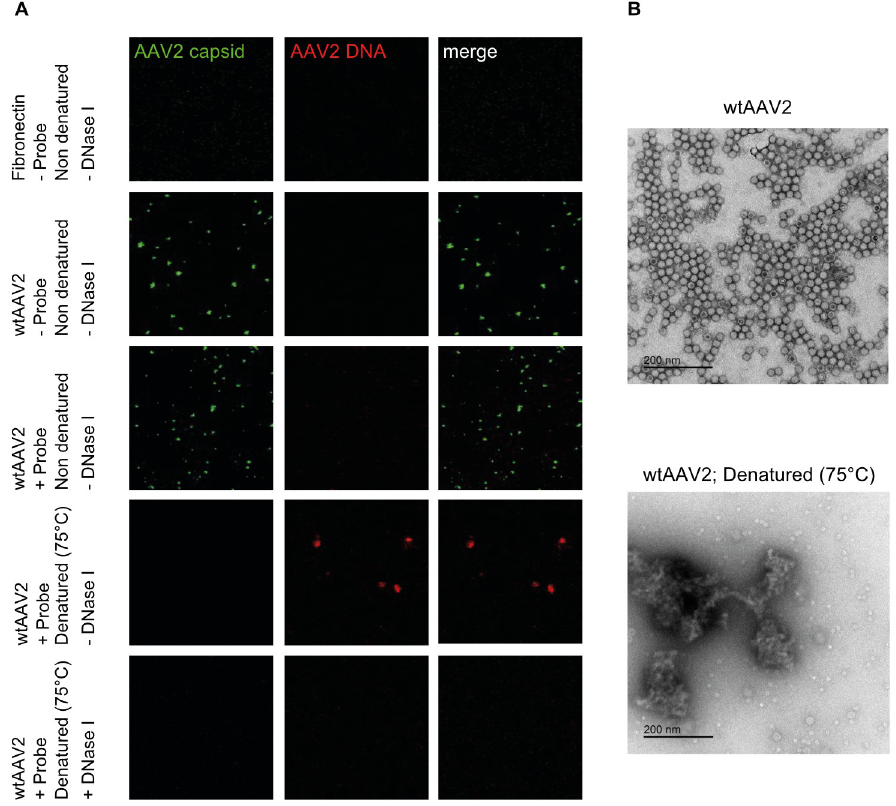
Fig 2. AAV2 particles on fibronectin coated coverslips. (A) wtAAV2 particles were directly applied to fibronectin coated coverslips and processed for IF analysis combined with FISH and CLSM, exactly as described for Fig 1. Intact capsids were stained using an antibody that detects a conformational capsid epitope (green). AAV2 DNA (red) was detected with an Alexa Fluor (AF) 647 labeled, amine-modified DNA probe that binds to the AAV2 genome. (B) Electron photomicrographs show complete disintegration of the AAV2 capsids at